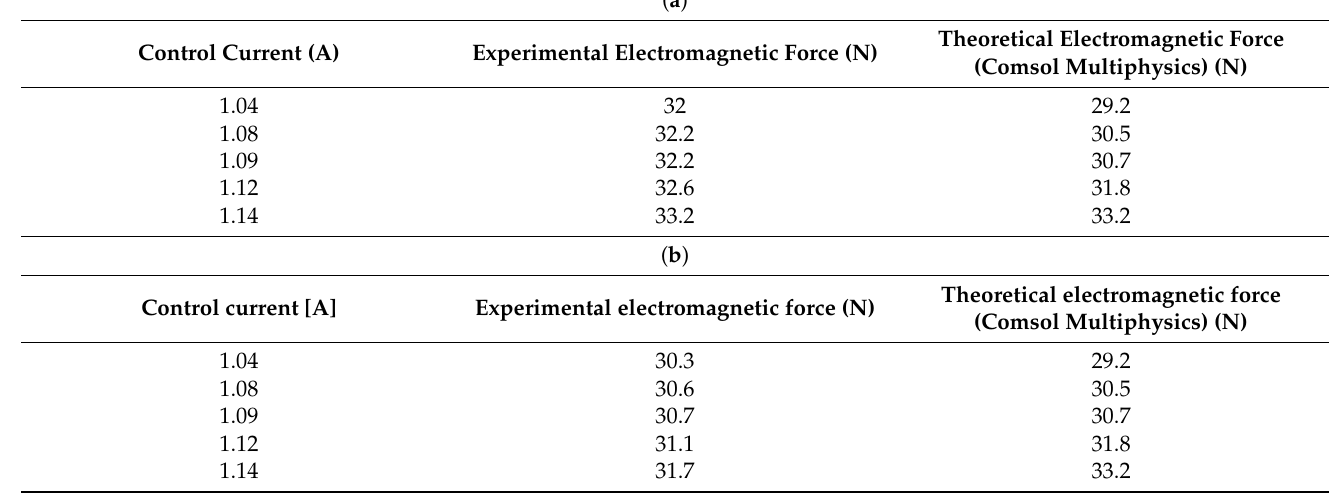
Table 5. The resultant electromagnetic forces generated by the magnetic bearing for different control current values for the constant rotor–shaft raceway displacement equal to − 0.04 mm and coeffi- cients kx and ki were obtained analytically ( a ); the resultant electromagnetic forces generated by the magnetic bearing for different values of the control current for the constant rotor–shaft raceway dis- placement equal to − 0.04 mm, where coefficients k x and k i were obtained using Control Multiphysics software ( b ).